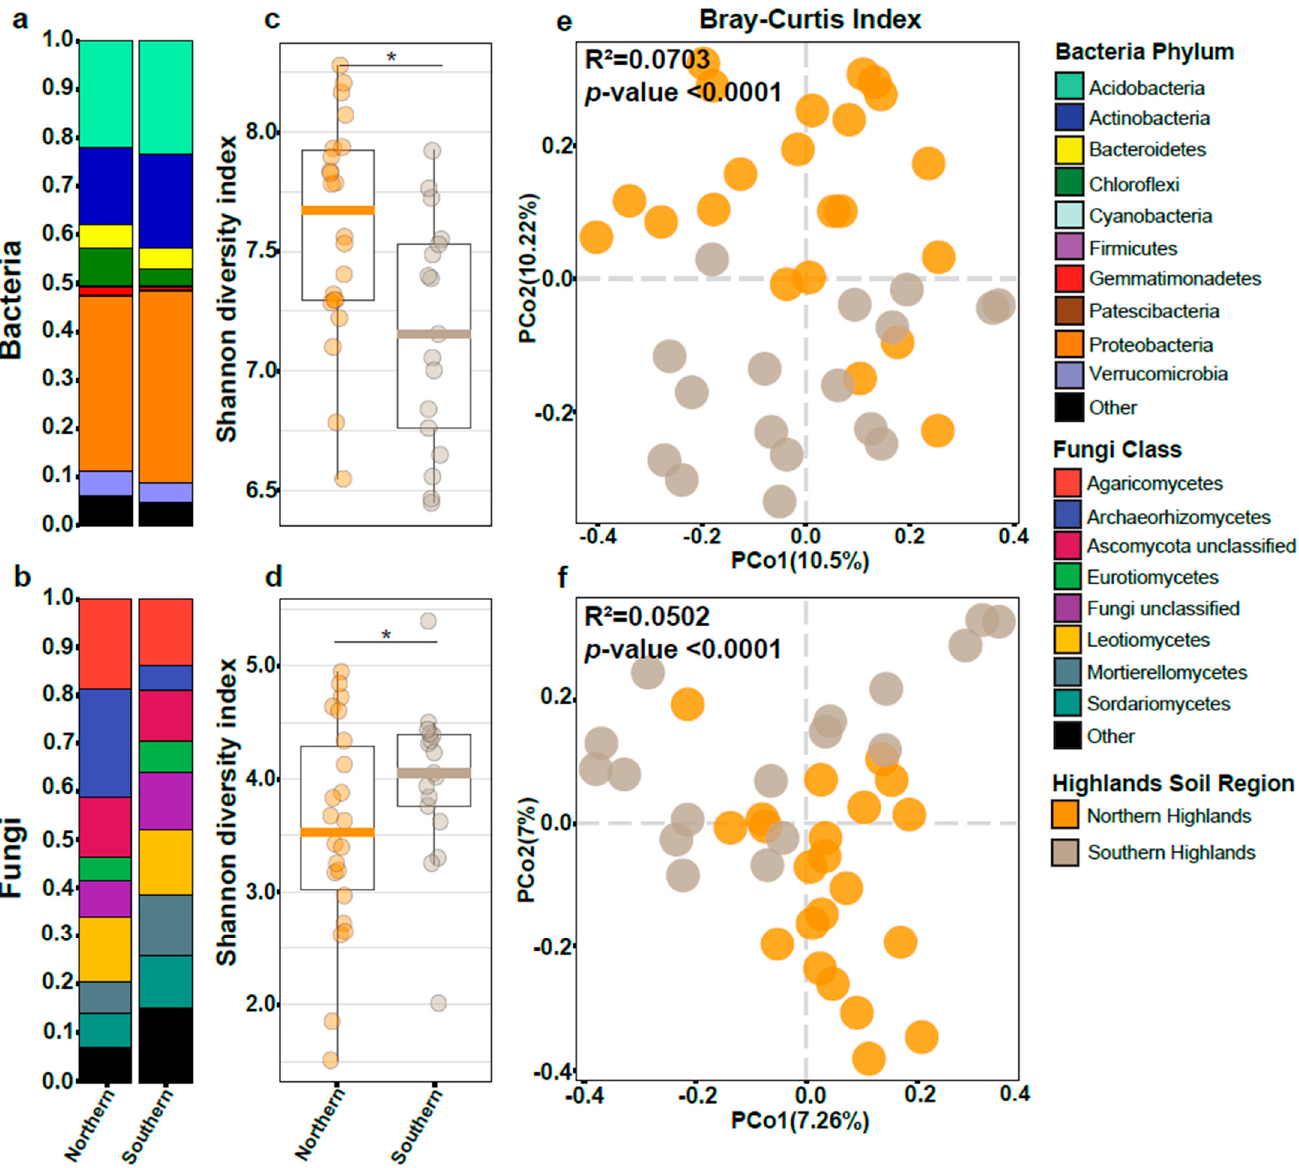
Figure 2. Bacteria and fungi rhizosphere microbiome analysis of the Andean Blueberry from the northern and southern Highlands. Microbiome composition for bacteria ( a ) and fungi ( b ). Boxplot of the entropy (Shannon Diversity Index) for bacteria ( c ) and fungi ( d ). * represents significant dif- ferences using t -Student test ( p value < 0.001). Principal Coordinate Analysis based on Bray–Curtis dissimilarities between bacterial ( e ) and fungal ( f ) communities across Highland soil regions. The variance explained ( R 2 ) and the significance ( p -value) are shown for a PERMANOVA model.